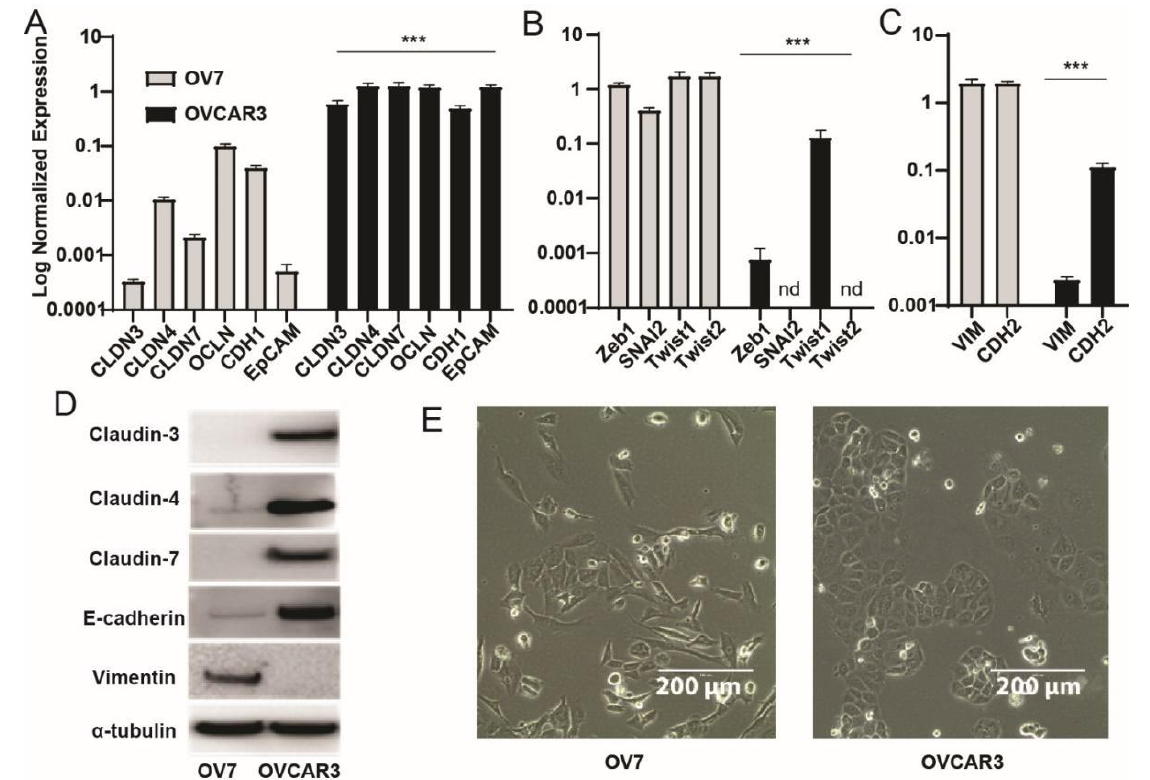
Figure 2. OV7 cells express EMT and stem cell markers. ( A – C ) RT-qPCR measurement of mRNA levels of epithelial markers, EMT-regulating transcription factors and mesenchymal markers in OV7 and OVCAR3 cells. Values are given as normalized expression relative quantification and displayed on Log scale. Error bars represent the mean ± SD of three independent experiments. ***, p < 0.001 independent samples t -test comparing individual markers between OV7 and OVCAR3 cells. ( D ) OV7 and OVCAR3 cell lysates were analyzed by western blot analysis with epithelial-specific (rabbit anti-claudin 3, mouse anti-claudin 4, mouse anti-claudin 7, ThermoFisher Scientific, mouse anti-E-cadherin, R&D System) and mesenchymal-specific antibodies (mouse anti-Vimentin, Sigma-Aldrich) that confirmed a significant unbalance of OV7 towards a mesenchymal phenotype and of OVCAR3 towards the epithelial phenotype. Mouse anti-α-tubulin loading control (Sigma-Aldrich). ( E ) Analysis by phase-contrast microscopy showing marked morphological difference between OV7 and OVCAR3 cells (scale bar 200 µm).